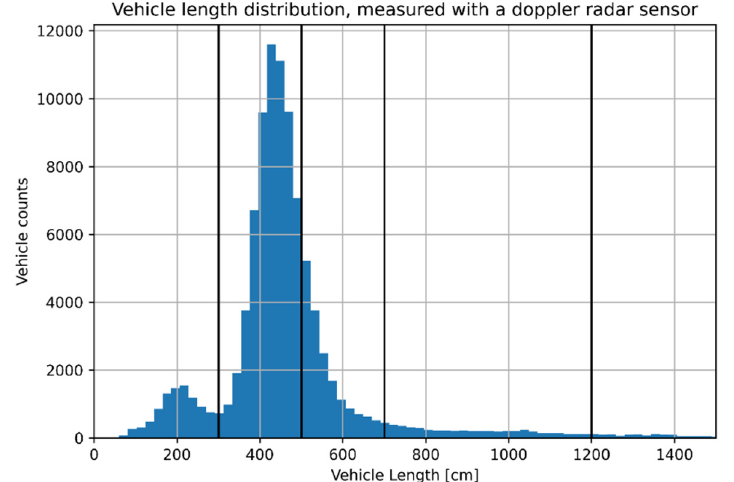
Figure 1. Vehicle length distribution measured using a radar Doppler sensor used in Piombino.